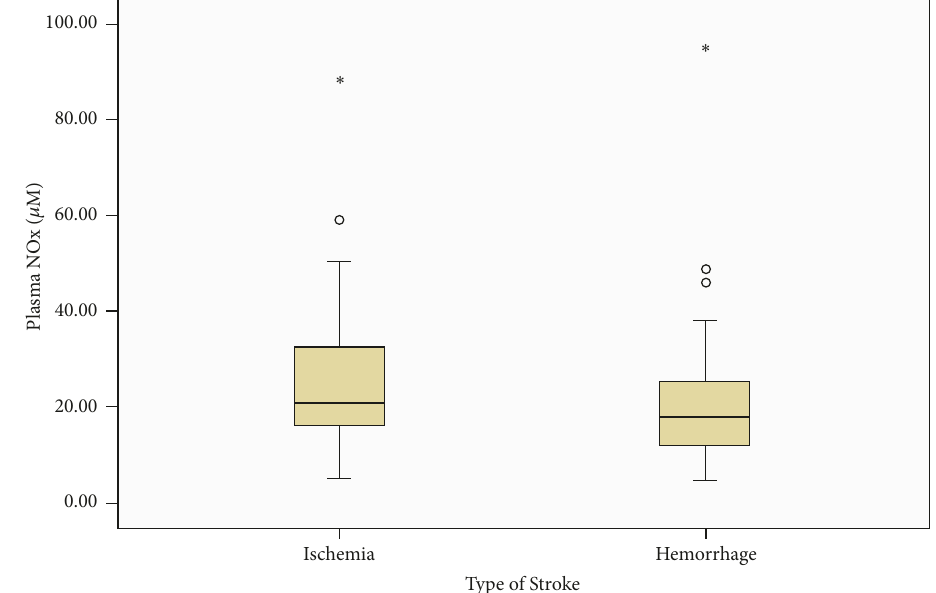
Figure 2: Absolute median NOx concentrations in patients presenting to the ED of Aga Khan University Hospital with ischemia or hemorrhage. Data are shown as box plots with the heavy line in the box representing the median ( 50 th percentile) and the ends of the box representing 25 th and 75 th percentiles, respectively. Groups were compared using the nonparametric Mann-Whitney U test